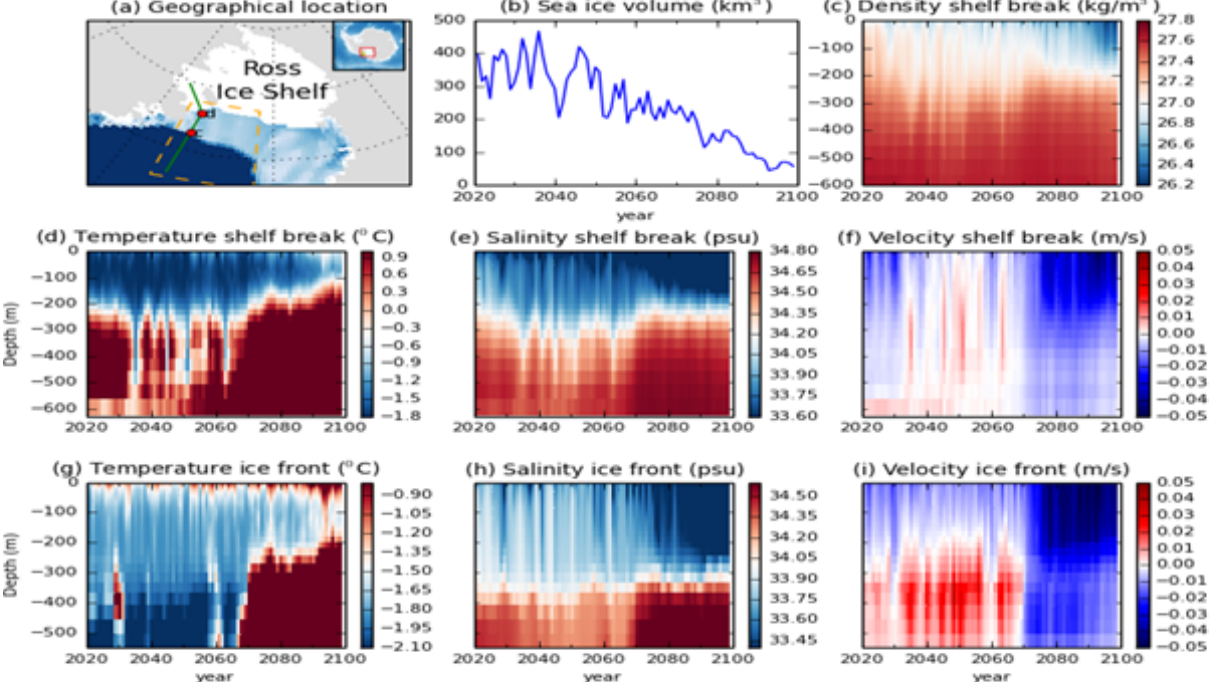
Figure 10. Little America Basin profile in the SSP5–8.5 scenario. (a) The chosen section on the Little America Basin is indicated by the green line segment between red dots c and d. The entire green line denotes the meridional section used in Fig. 11. The dark- and light-blue colours represent the deep ocean and the continental shelf in the Ross Sea, respectively, whereas the grey and white colours represent the grounded ice sheet and the Ross Ice Shelf, respectively. (b) Sea ice volume on the area enclosed by the orange dashed lines in (a) . (c–f) The time series of potential density, temperature, salinity and meridional velocity, respectively, at the shelf break indicated by red dot c in (a) . (g–i) The time series of temperature, salinity and meridional velocity at the ice front indicated by red dot d in (a)